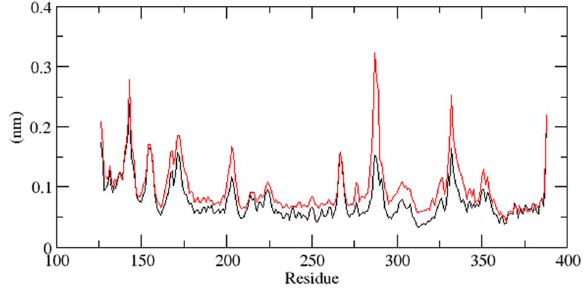
significant correlation was observed for other cancer cases.